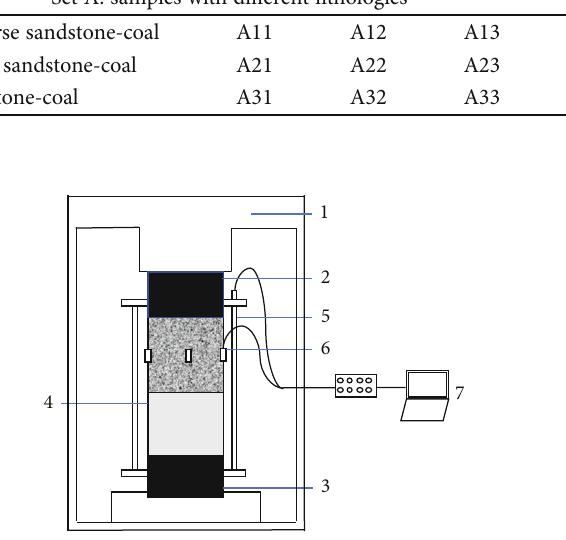
Figure 6: Schematic diagram of the deformation of the coal – rock combination under an external force: (a) combination samples with di ff erent lithologies; (b) combination samples with di ff erent height ratios. Table 1: Experimental design. Set B: samples with di ff erent height ratios